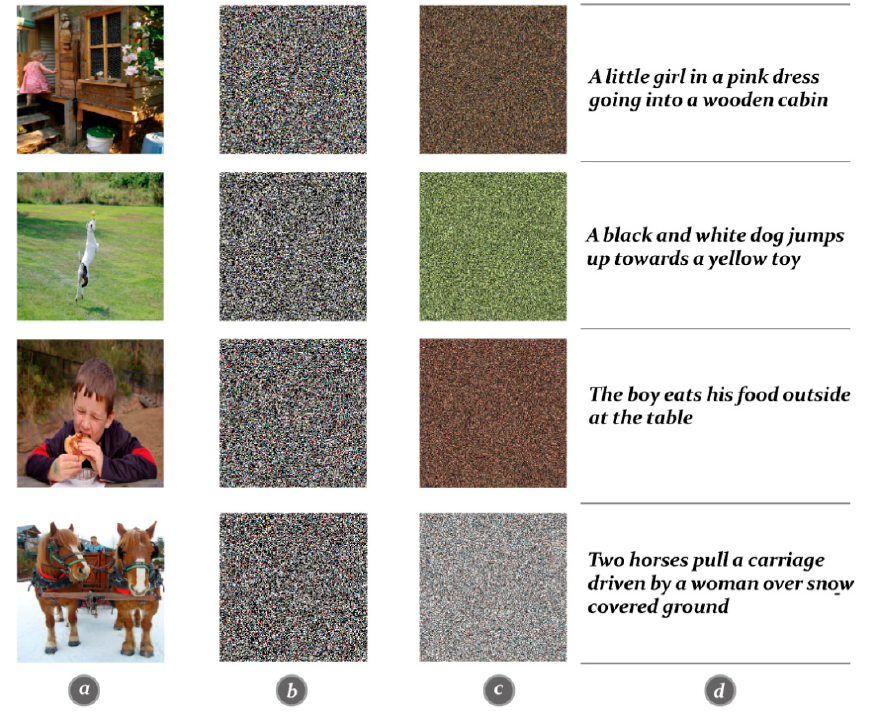
Figure 5. Illustration of DRPE-encrypted images. ( a ) Original image from the dataset, ( b ) phase part of the encrypted image, ( c ) amplitude part of the encrypted image, and ( d ) corresponding caption of the original image.